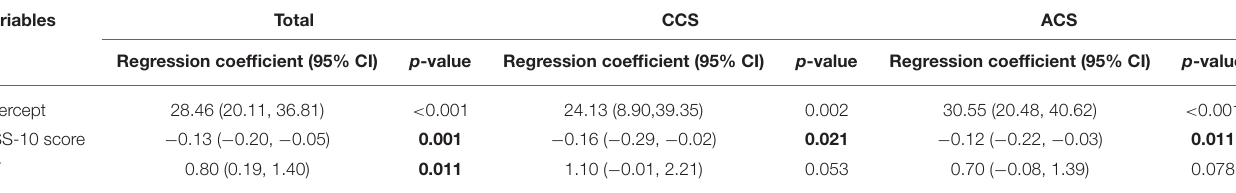
TABLE 3 | Multiple linear regression models of APTT in the patients with the chronic coronary syndrome (CCS) and acute coronary syndrome